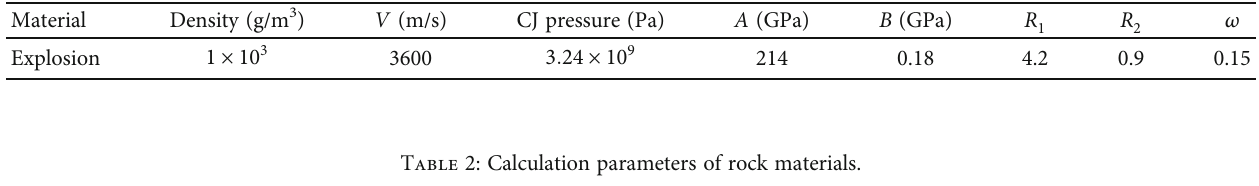
Table 1: Calculation parameters of JWL equation of state for explosives.